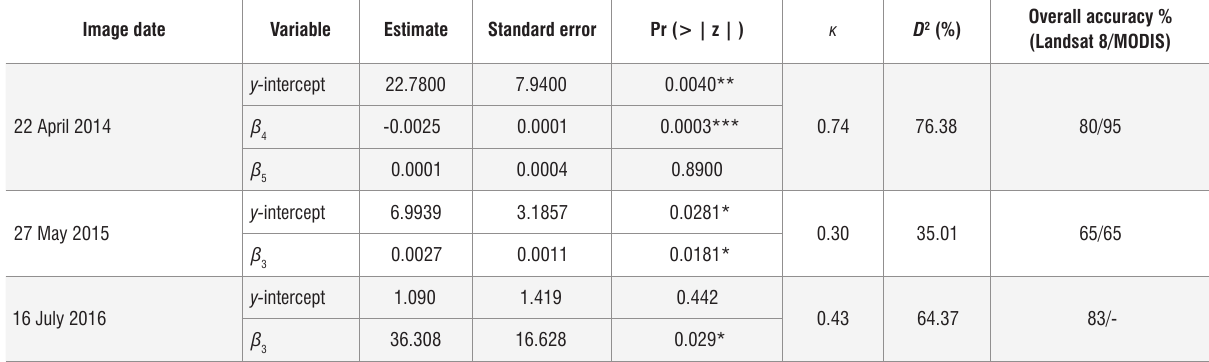
(difference vegetation β 3 index)